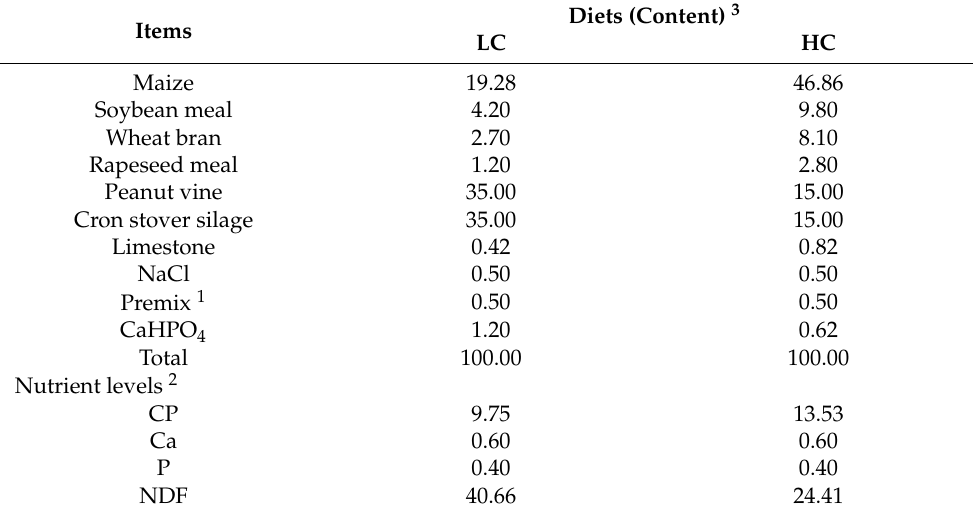
Table 1. Ingredients and nutrient contents of the experimental diets (DM basis,%).